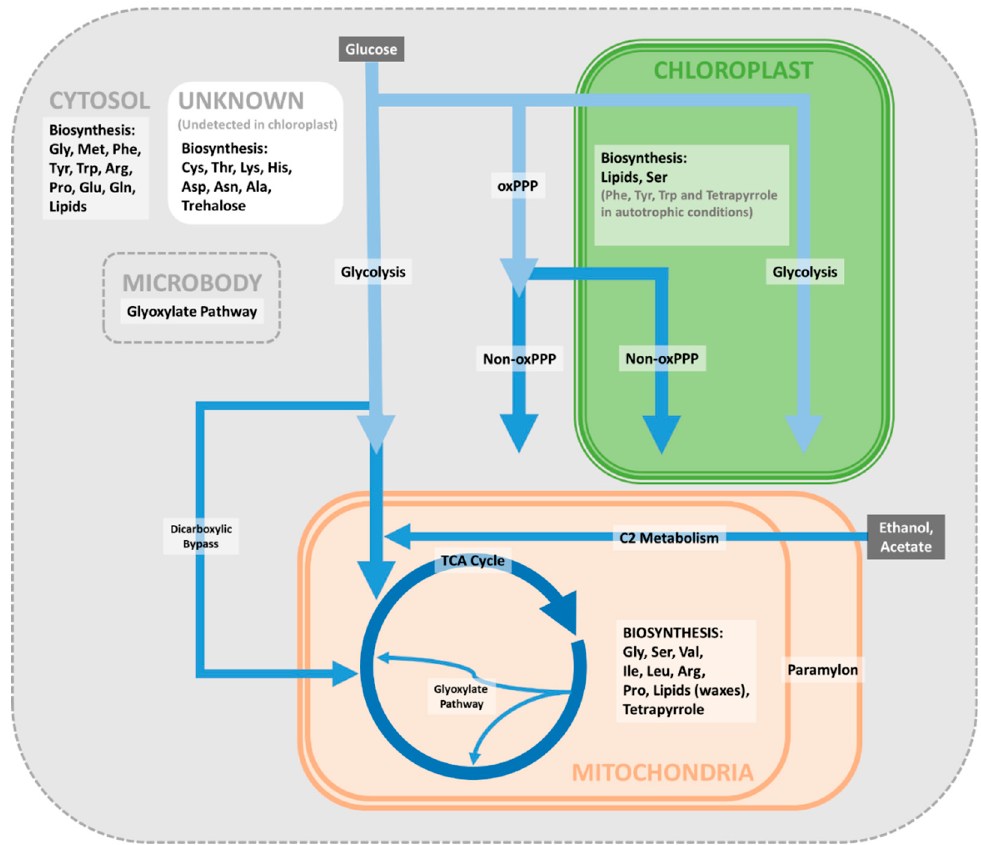
Figure 2. Proposed distribution of central metabolic pathways in Euglena . Abbreviations: oxPPP—oxidative pentose phosphate pathway; Non-oxPPP—non-oxidative pentose phosphate pathway.